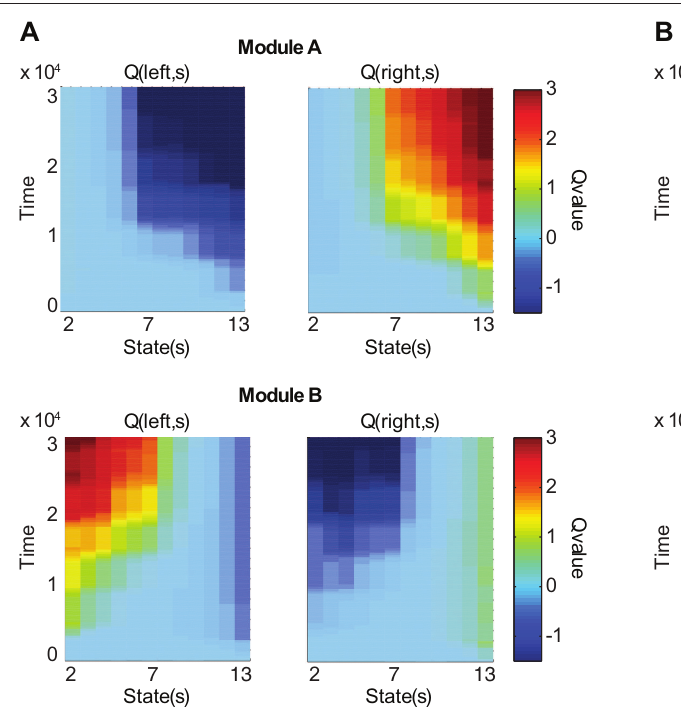
Figure 3 | Action value, prediction, and state value functions of the two modules as the model learns in two versions of the environment. The reward location alternates every 2500 time steps. Columns represent different locations. States (locations) 2 through 13 are shown; terminal locations are omitted. (A) Action value ( Q ) as a function of state and time. Top two panels represent the action-value function of module A and bottom two panels represent that of module B. Left panels show the values for leftward movements and right panels show the values for rightward movements. After training,